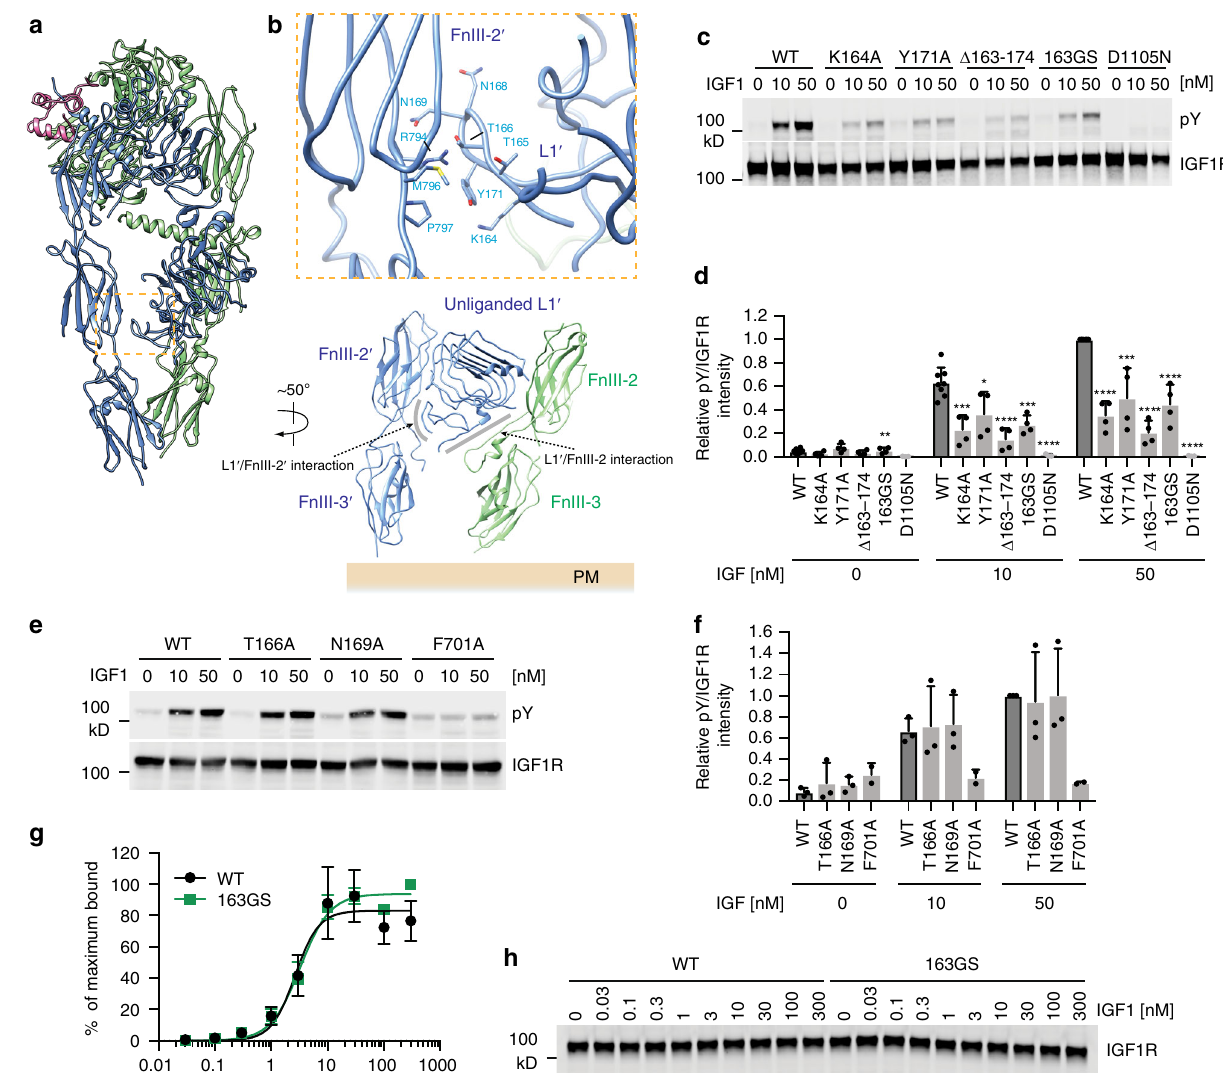
Fig. 5 L1 ′ /FnIII-2 ′ interaction in the active-IGF1R dimer. a Overall view of IGF1R active dimer, showing in two different views. b Close-up view of the L1 ′ / FnIII-2 ′ interaction. The location of this interaction in the IGF1R active dimer is indicated by an orange box in a . c IGF1-induced IGF1R autophosphorylation in 293FT cells expressing WT IGF1R or indicated mutants. The kinase dead mutant (D1105N) was used as a negative control. d Quanti fi cation of the western blot data shown in c (Mean ± SD). Each experiment was repeated four times. Signi fi cance calculated using two-tailed students t-test; between WT and mutants; * p < 0.05, ** p < 0.01, *** p < 0.001, and **** p < 0.0001. e IGF1-induced IGF1R autophosphorylation in 293FT cells expressing WT IGF1R or indicated mutants. The IGF1-binding mutant (F701A) was used as a negative control. f Quanti fi cation of the western blot data shown in e (Mean ± SD). Each experiment was repeated three times. g Binding of IGF1 labeled with Alexa Fluor 488 to 293FT cells expressing IGF1R WT or 163GS (Mean ± SD). Each experiment was repeated three times. h Representative western blot images of the amount of IGF1R in g . Source data are provided as a Source Data fi